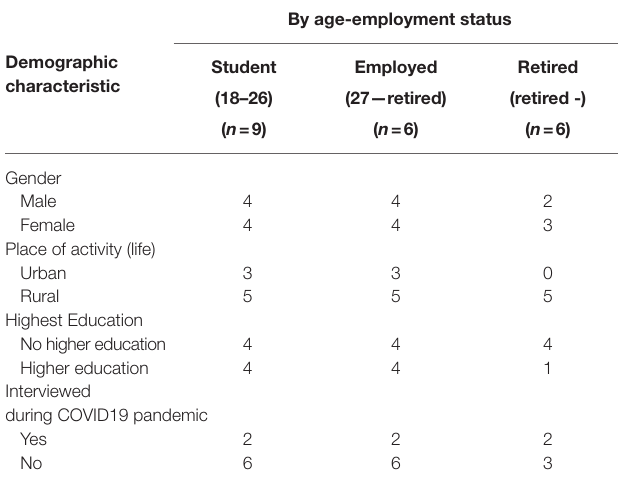
TABLE 1 | Demographic information for